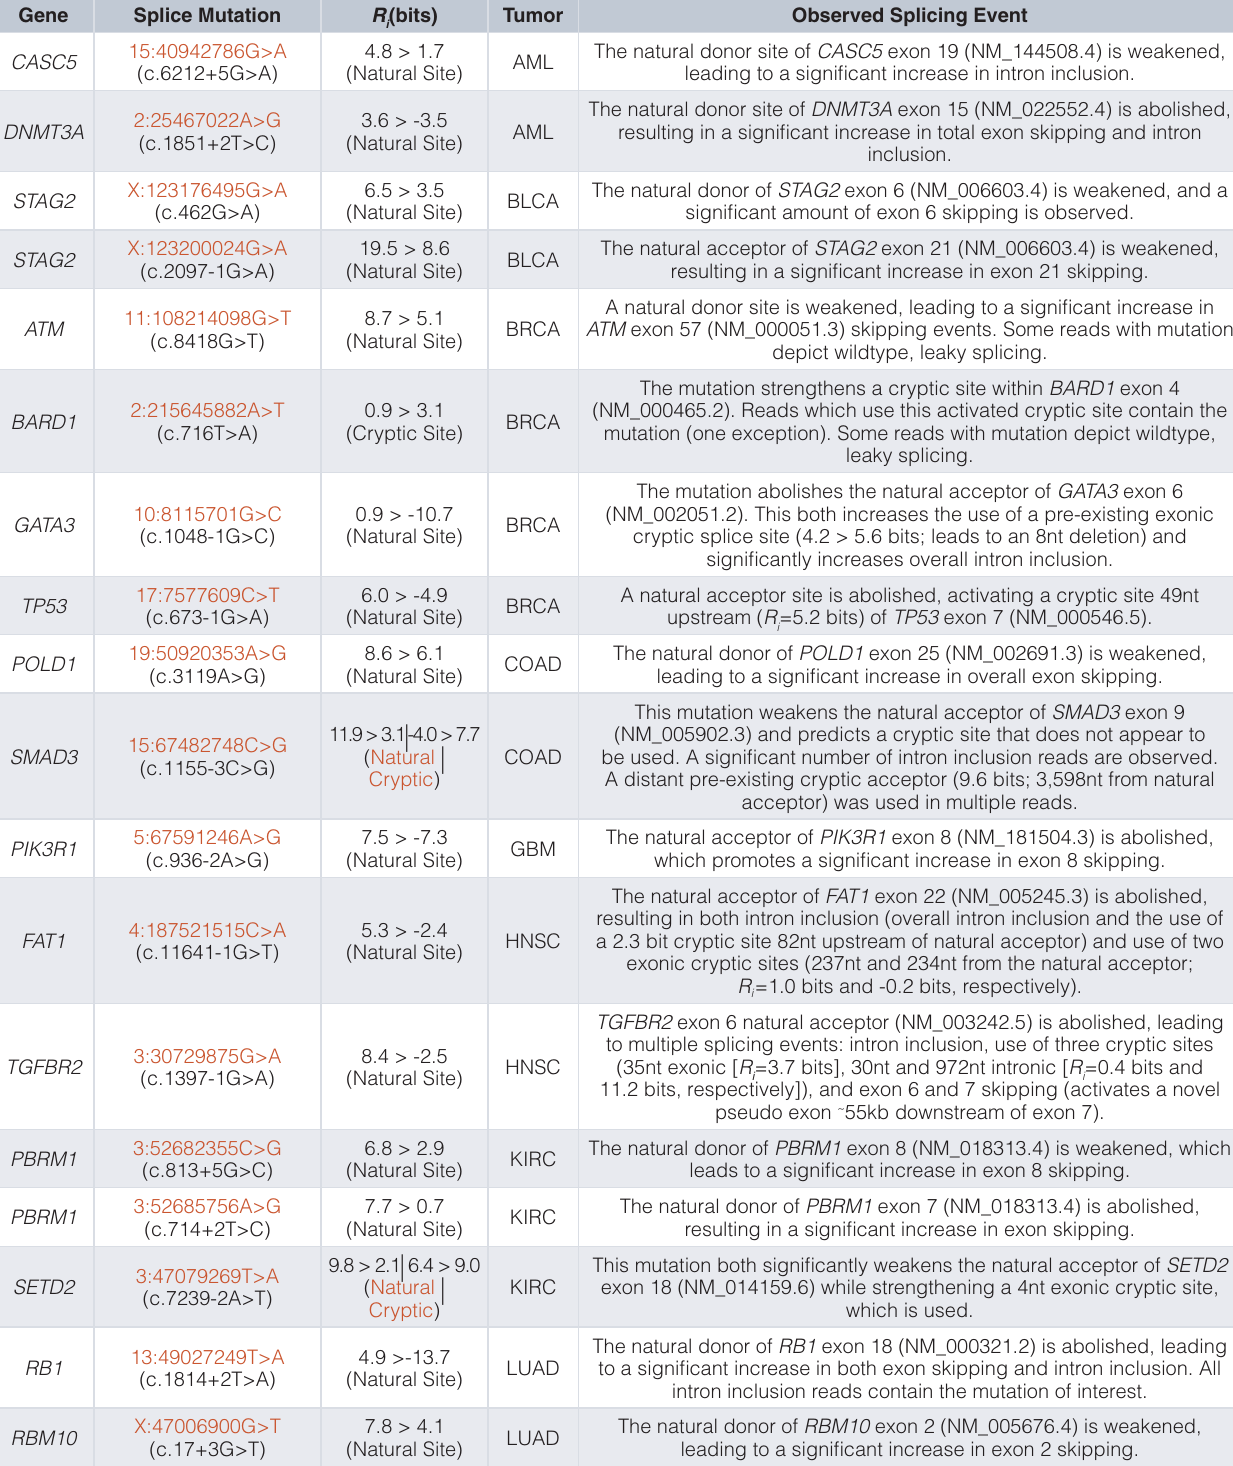
Table 2. Representative Validated Splicing Mutations in COSMIC Cancer Gene Census